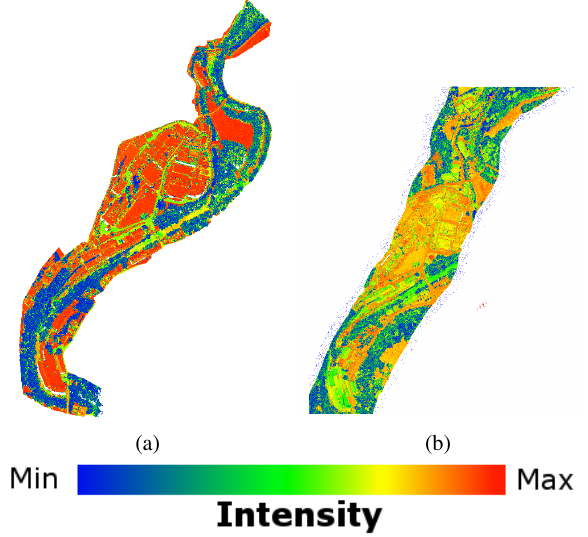
Figure 3. Overview of the LiDAR data of the test side. (a) data from 2012, captured with a Riegl VQ 820G, (b) data from 2017, captured with a Riegl VQ 880G.